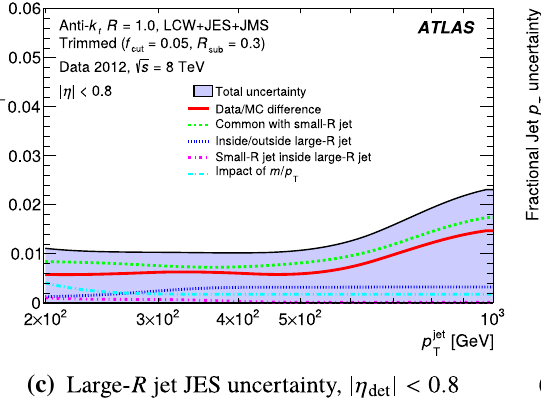
Fig. 34 Statisticalandsystematicuncertaintiesinthedata-to-MCratio of R DB for trimmed R = 1 . 0 anti- k t jets calibrated with the LCW+JES scheme with a , c | η det | < 0 . 8 and b , d 0 . 8 ≤ | η det | < 1 . 2. The uncer- tainties are evaluated in bins of p ref , converted to jet p T , and translated T into a function using a Gaussian kernel smoothing. a , b highlight the